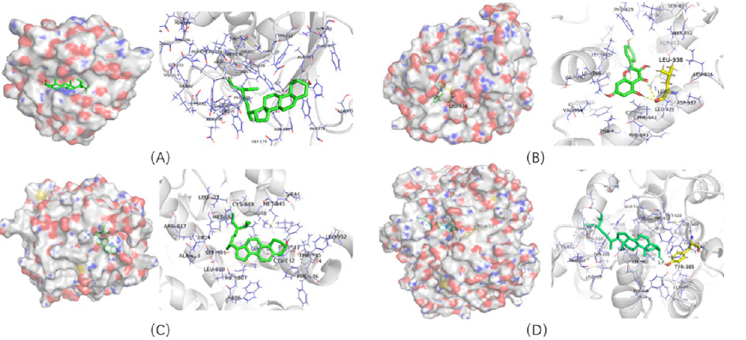
Fig 11. Part of molecular docking results. (A). Stigmasterol—MMP1; (B). kaempferol—NR3C2; (C). Stigmasterol— NR3C2; (D). Stigmasterol—PTGS2. The compound structure was presented as a green stick, the protein structure was presented as a gray ribbon and the interacted residues were shown as a red and blue lines